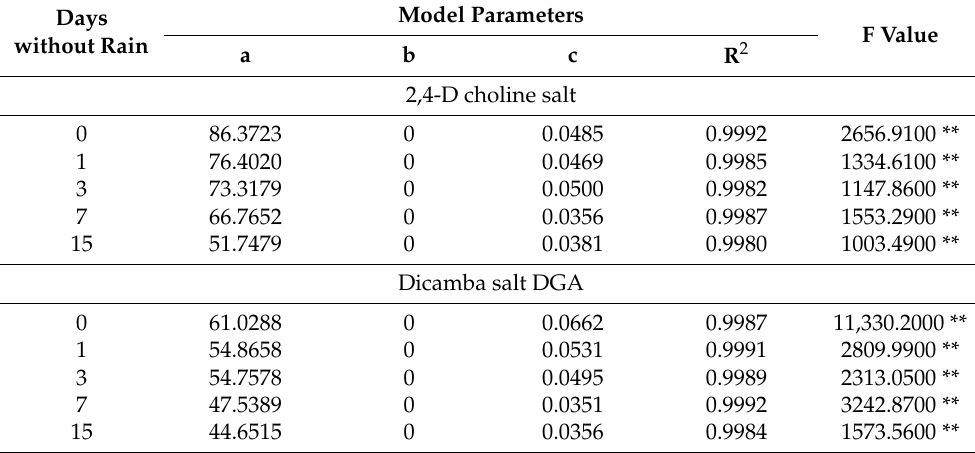
Table 2. Estimates of the parameters of the Mitscherlich model adjusted for the concentrations of 2,4-D and dicamba leached from corn straw (5 t ha − 1 ) as a function of the days after application and simulations of different rainfall amounts